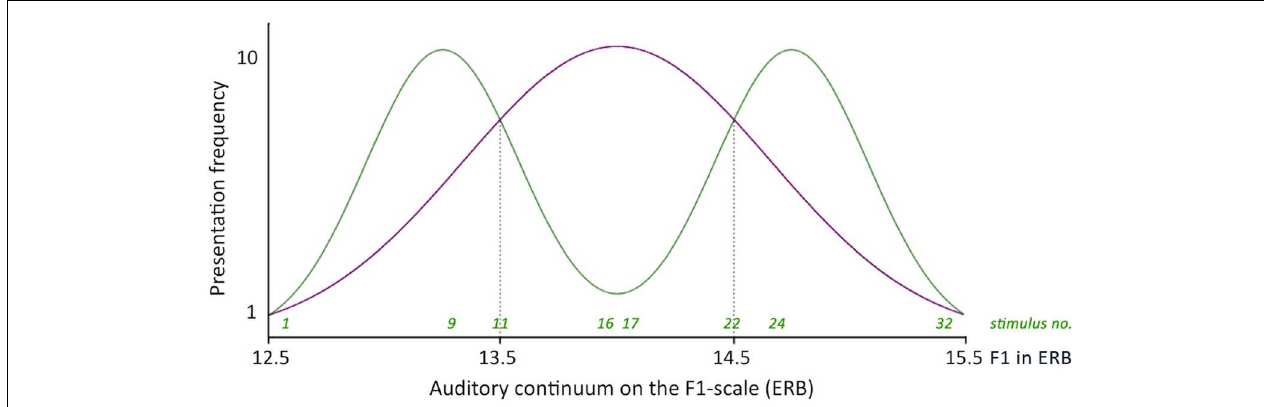
FIGURE 2 | Simplified frequency distributions of the one- and the two-peaked 32-step auditory continuum. Dotted lines indicate the intersections between the two distributions, which correspond to stimuli 11 and 22 on the continuum (the test stimuli).